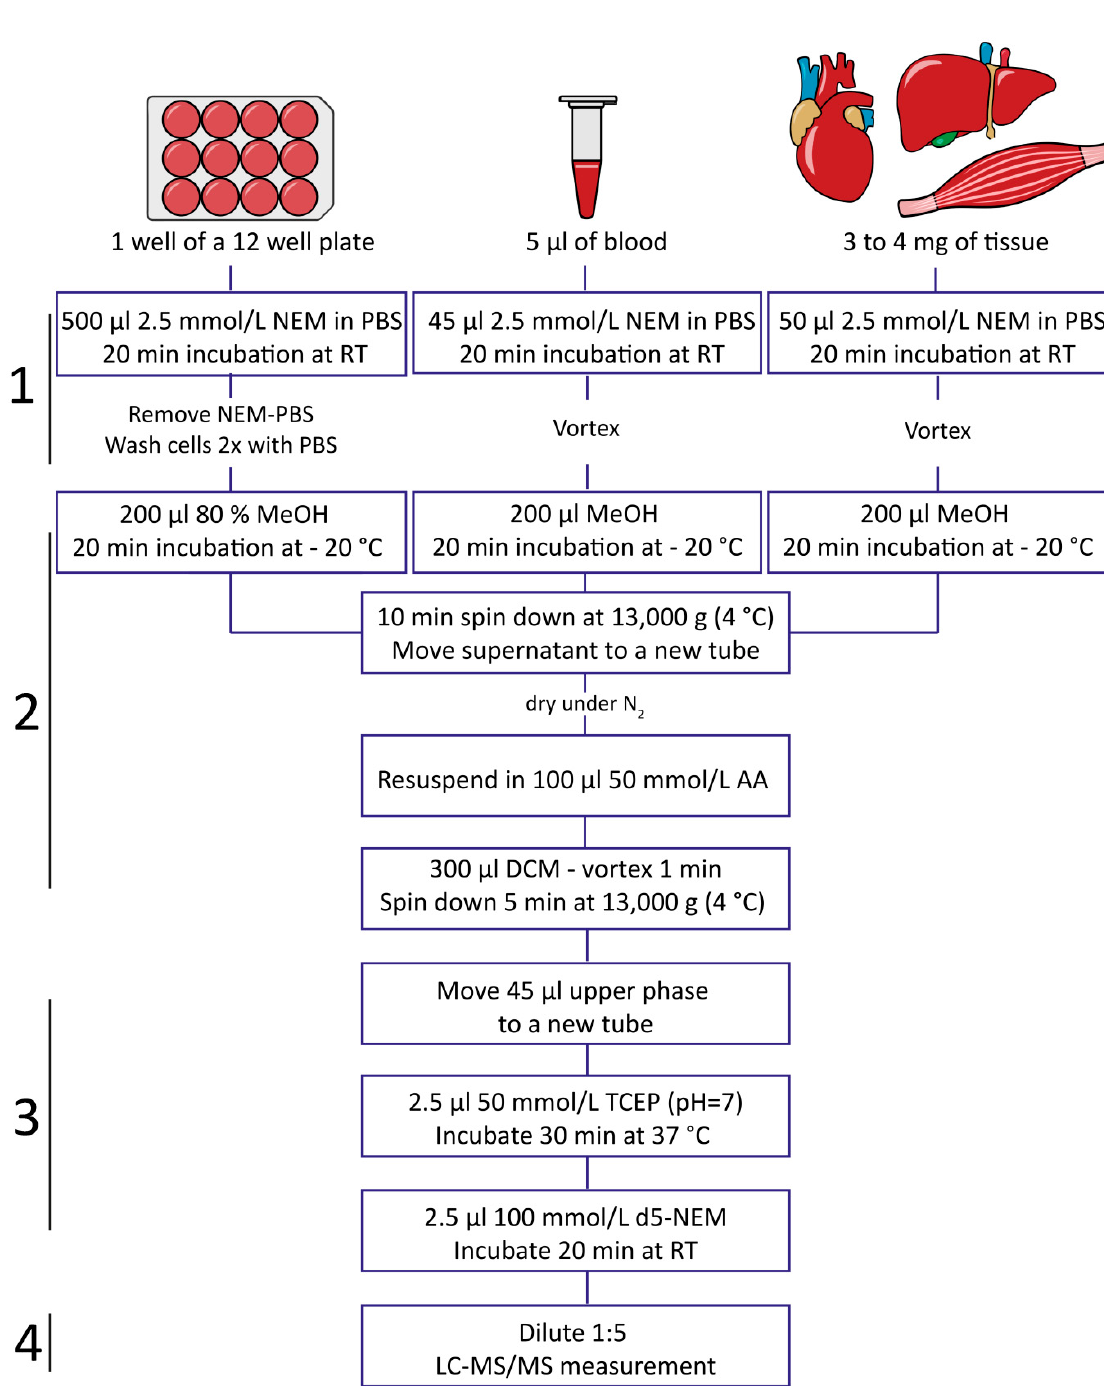
Figure 1. Workflow of reduced-to-oxidized-glutathione ratio determination by isotope labeling. In the first step (1), N-ethylmaleimide (NEM) was used to derivatize free glutathione (GSH) in a sample-type-specific manner. So far, the method has been optimized but is not limited to cells, blood, and tissues. In the following step (2), proteins and excess NEM were removed by methanol (MeOH) precipitation and dichloromethane (DCM) extraction. Next (3), non-protein-bound oxidized thiols in the samples (including oxidized glutathione (GSSG)) were reduced and newly formed GSH was then derivatized to GSH-d 5 -NEM. Finally, all analytes were measured simultaneously by multiple reaction monitoring (MRM)-based LC-MS/MS (4). Corresponding chemical reactions are displayed in Suppl. Figure S1. PBS: phosphate-buffered saline, RT: room temperature, AA: ammonium acetate. After all free GSH was quenched, cold 80% methanol (MeOH) was used to precipitate and remove proteins from the sample (Figure 1, step 2). At this step, the internal standard (IS) can be